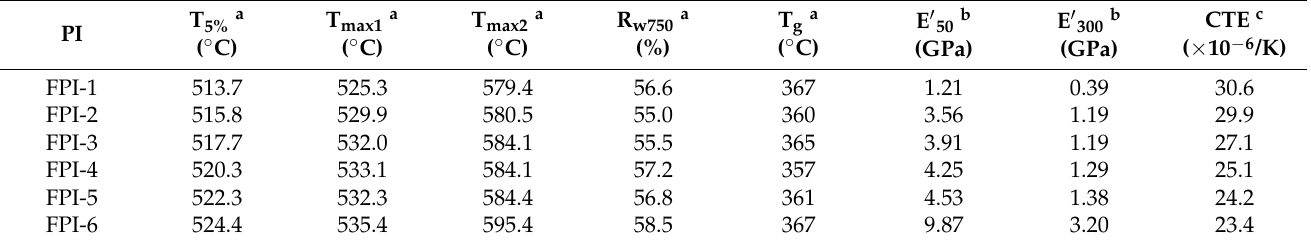
Table 4. Thermal properties of the FPI films.